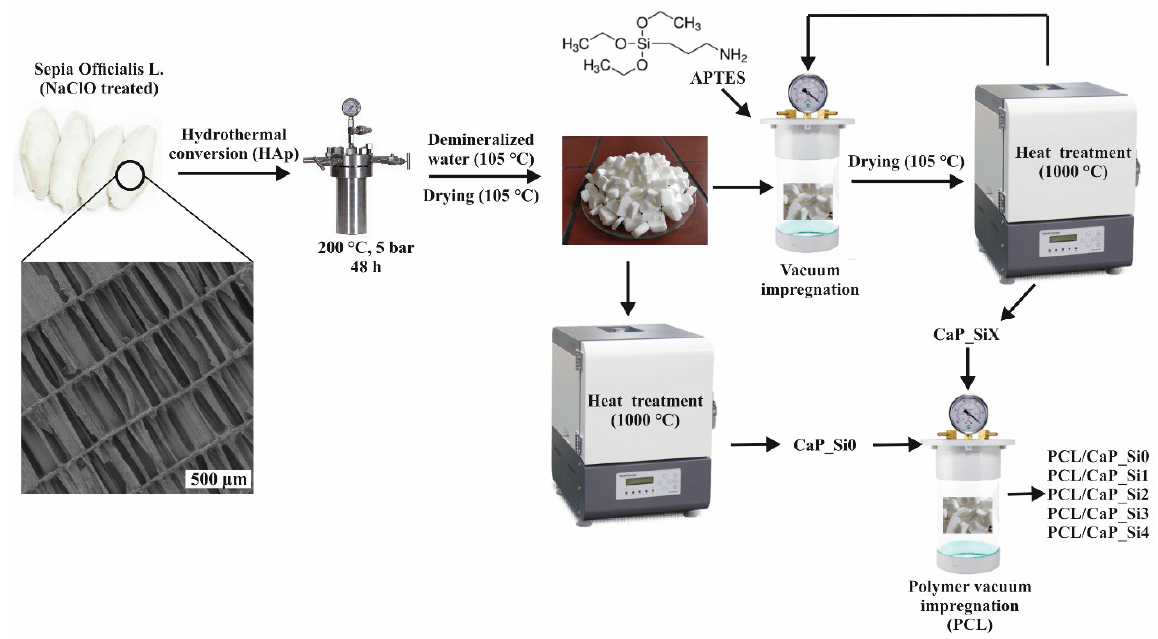
Figure 1. Schematic illustration of PCL/CaP_Si scaffold preparation. The first step involves the hydrothermal conversion of the cuttlefish bone aragonite structure into hydroxyapatite scaffolds, followed by impregnation with APTES and heat treatment. The final step includes coating bioactive scaffolds with PCL solution to produce porous PCL/CaP_Si composites.